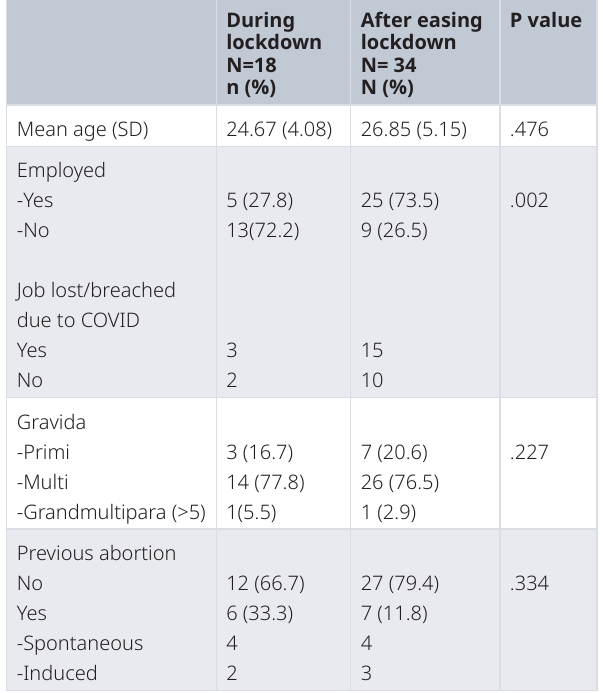
Table 1. Demographic and obstetric profile of patients coming for SAS during the pandemic. During lockdown